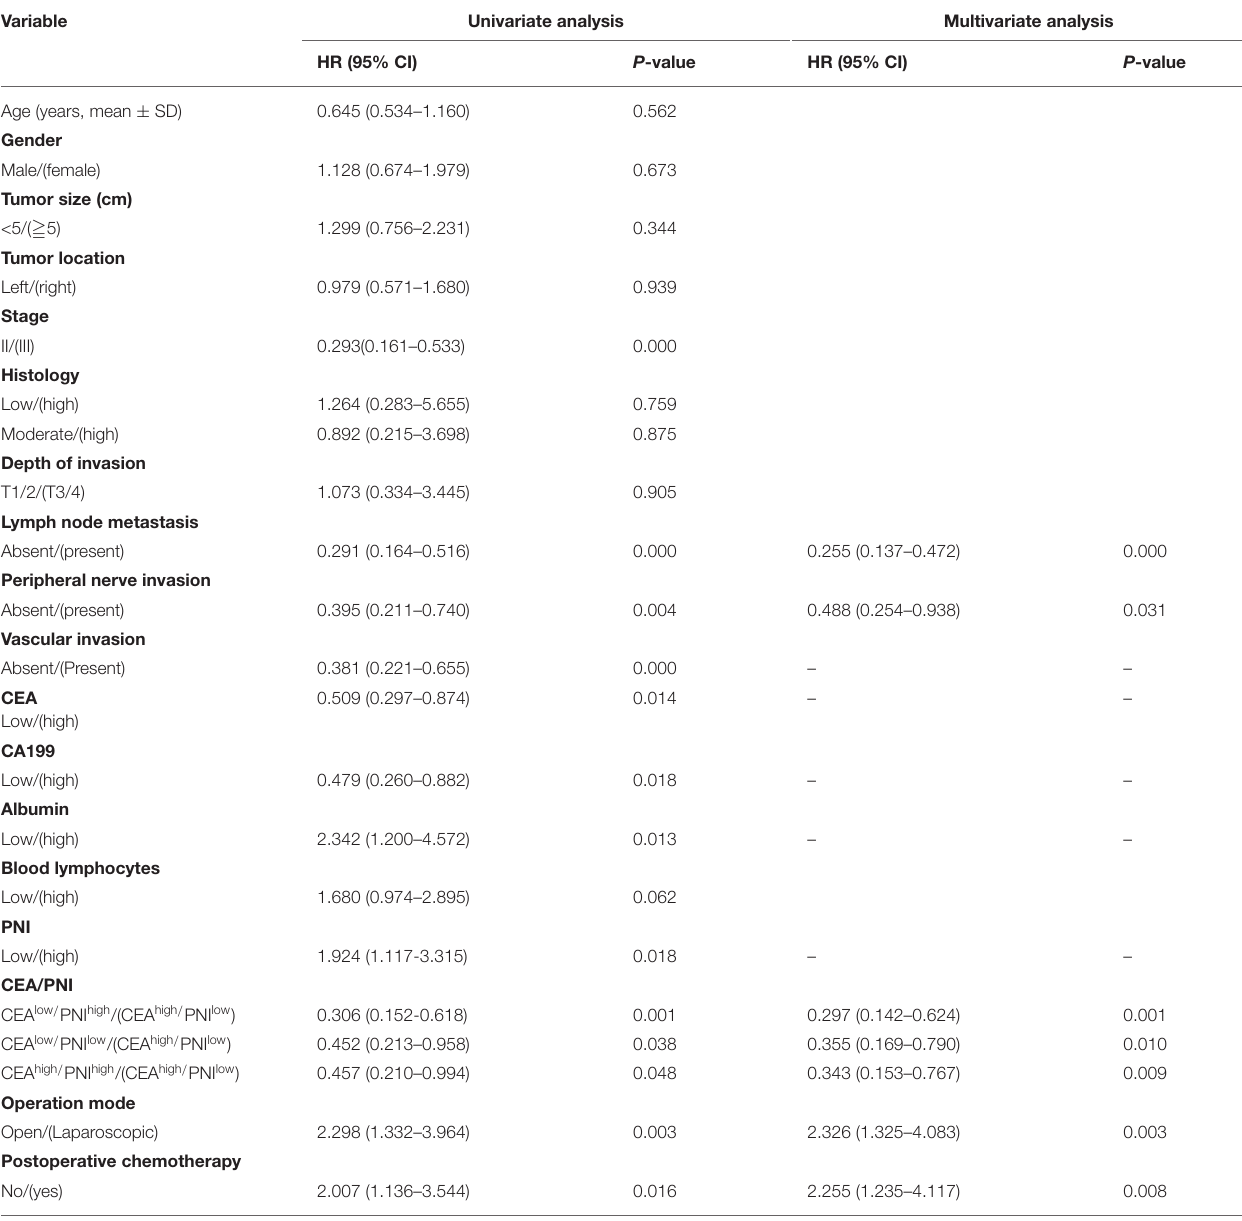
TABLE 2 | Univariate and Multivariate analyses of prognostic factors for overall survival in the learning set with stage II–III colon cancer.